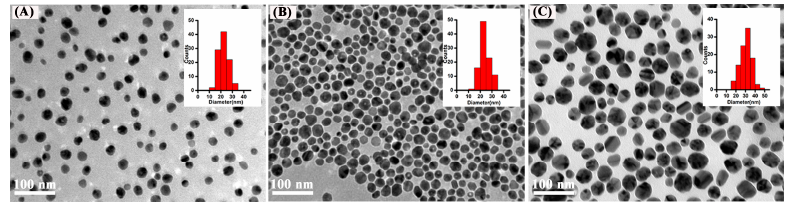
Figure 1. Representative TEM images of Ag NPs. ( A ) Ag-B; ( B ) Ag-CIT; and ( C ) Ag-PVP. The insert in each image shows the size distribution of the corresponding Ag NPs.